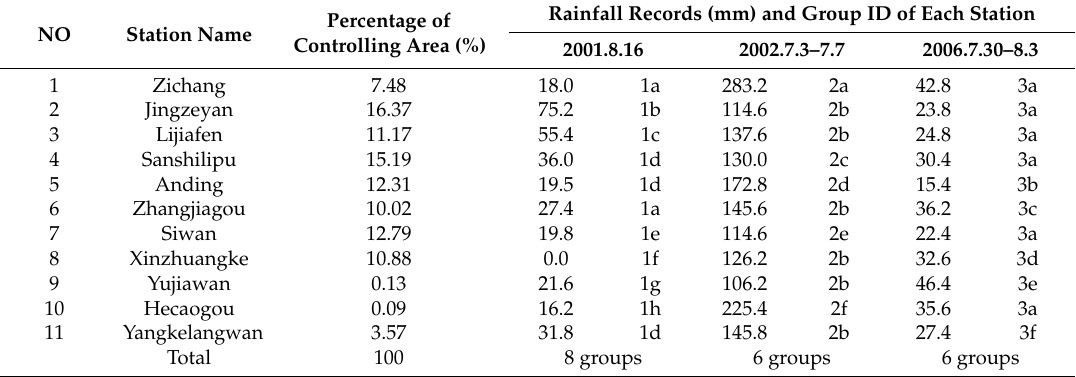
Table 4. Classification of rainfall stations for the three rainfall events.